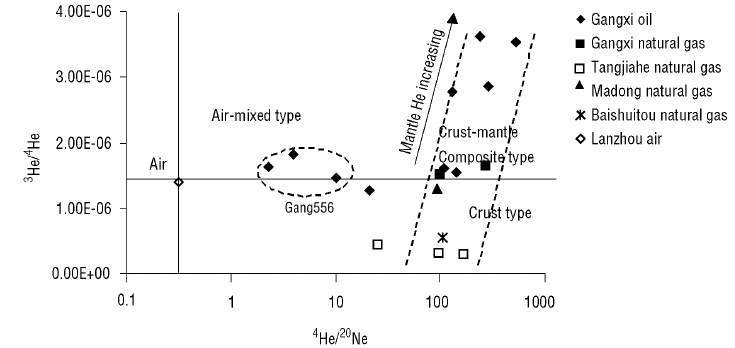
Fig. 5. Plot of 3 He/ 4 He versus 4 He/ 20 Ne of the crude oils from the Gangxi oil field.